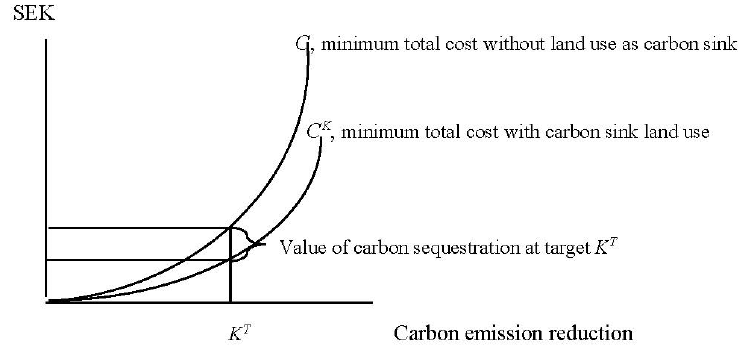
Figure 1. Illustration of the calculation of the value of land use as a carbon sink in a cost effectiveness framework. SEK: Swedish crown; K T : carbon emission reduction